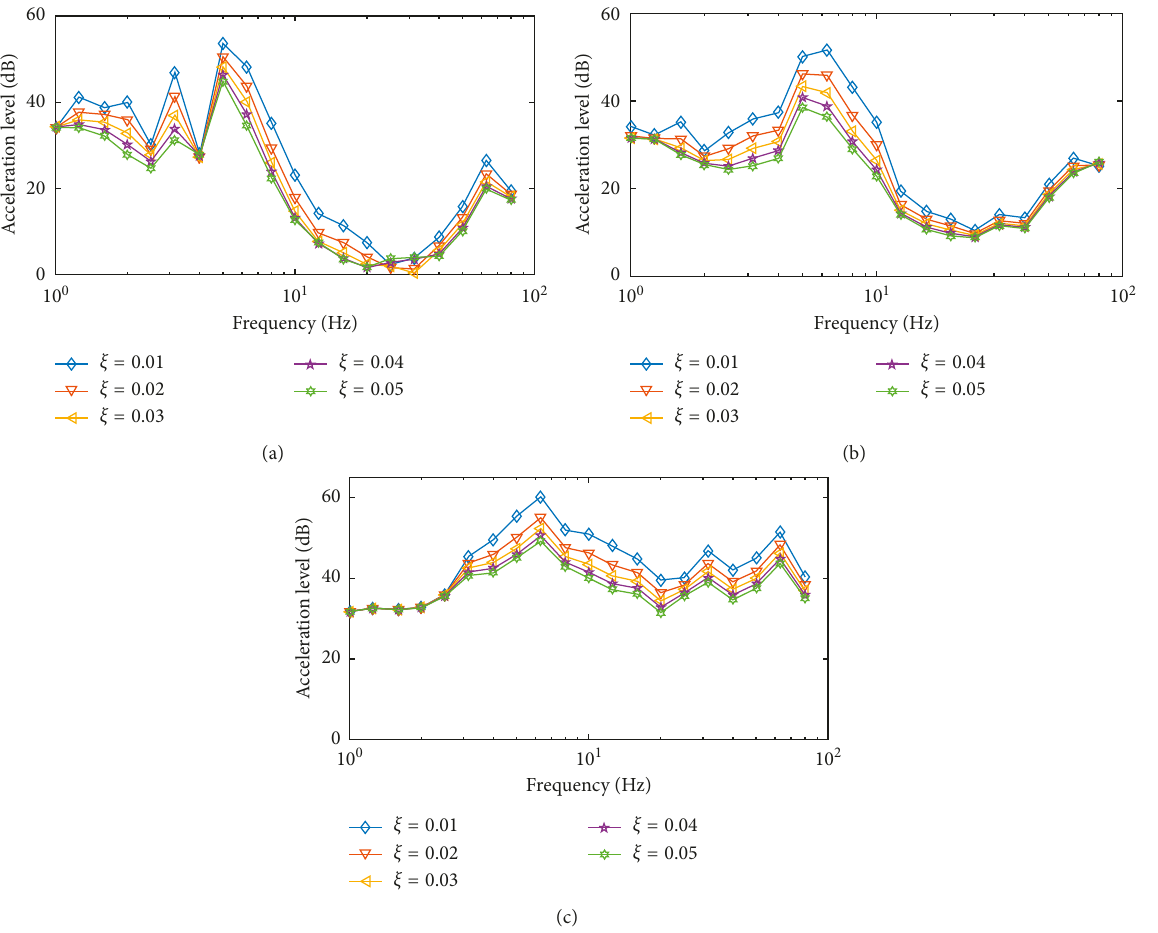
Figure 15: The average one-third octave spectra of the acceleration level of typical story (6 th story) for different damping ratio. (a) X direction. (b) Y direction. (c) Z